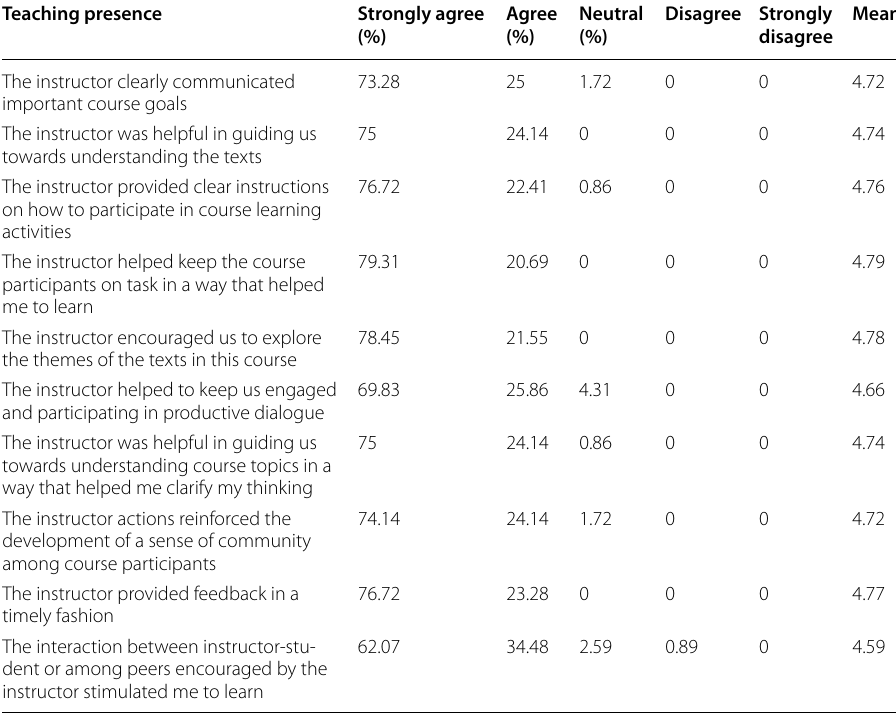
Table 2 Responses to questionnaire items for teaching